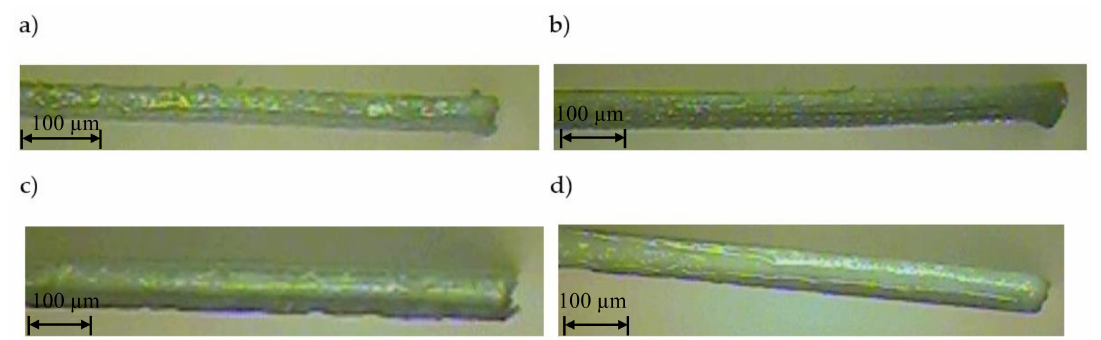
Figure 17. View of the cut surface in cross-section of the foil: ( a ) t = 50 µ m, ( b ) t = 60 µ m, ( c ) t = 70 µ m, ( d ) t = 80 µ